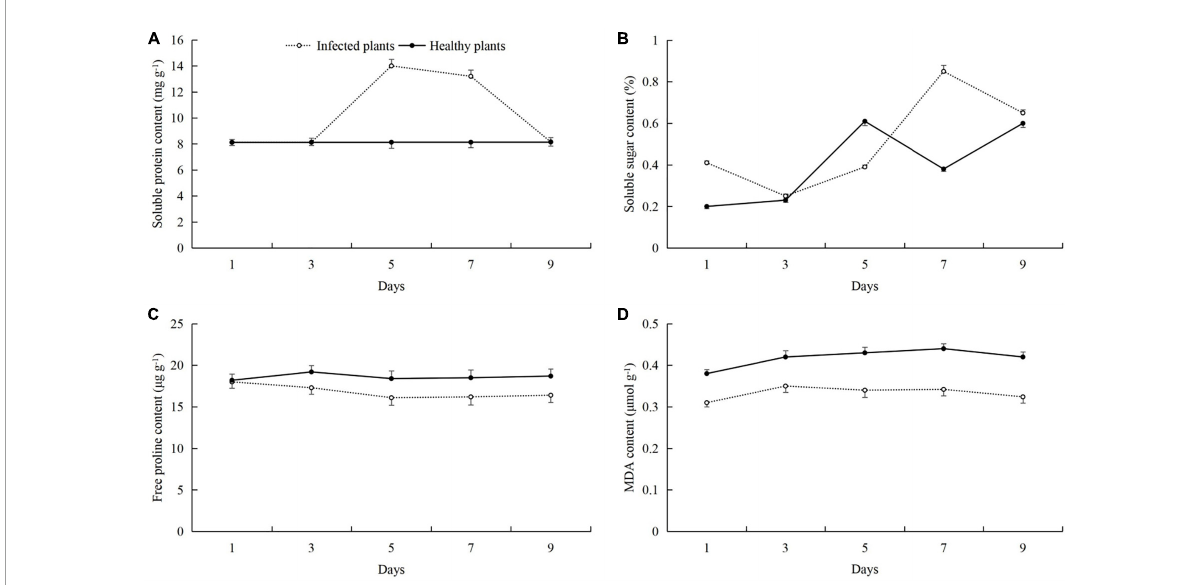
FIGURE2 Effects of powdery mildew infection on the contents of (A) soluble proteins, (B) soluble sugars, (C) free proline, and (D) malondialdehyde (MDA) in cucumber leaves.